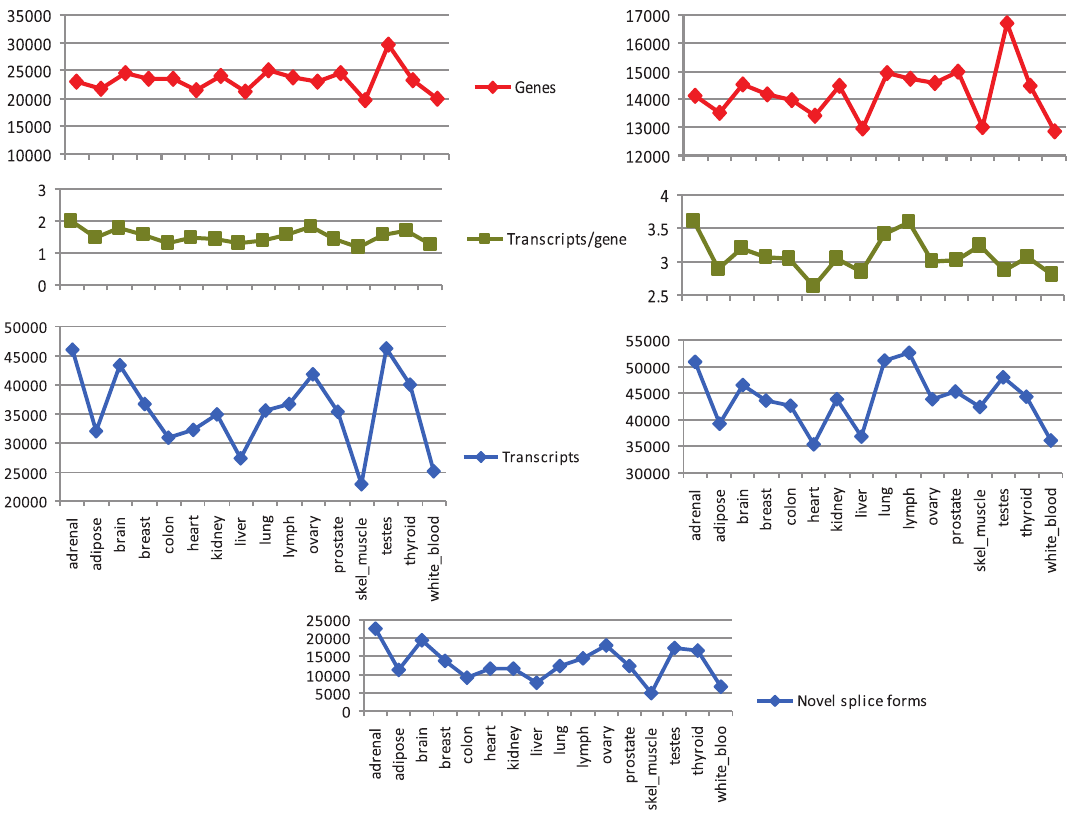
Figure 1. A high-level view of alternative splicing in sixteen human tissues: numbers of multi-exon ‘genes’ and transcripts from de novo transcript assemblies produced by Cufflinks (left), and by Cuffcompare (right). Since Cufflinks may break transcripts and genes into multiple fragments when there is insufficient read coverage, we used Cuffcompare to compare transfrags against the Ensembl reference annotations to produce a better estimate for the number of genes and transcripts in the samples. Results in the right panel show the total number of Ensembl annotated as well as novel genes, and respectively transcripts, found in each sample. The number of novel isoforms identified by Cuffcompare is shown in the bottom